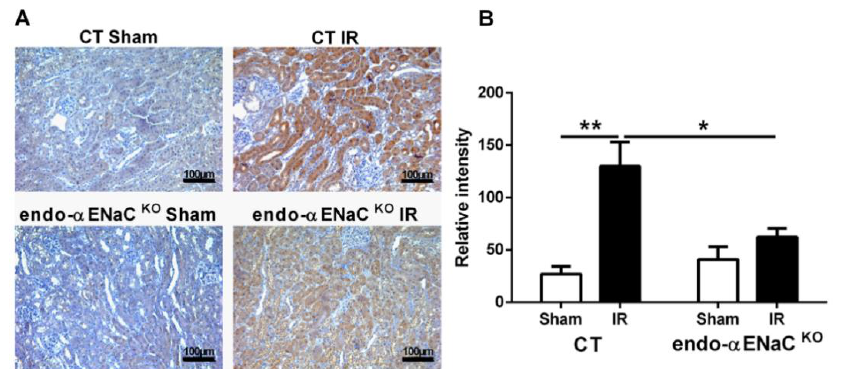
Figure 3. Endothelial αENaC deficiency promotes a faster recovery from hypoxia after IR . ( A ) Representative images from immuno-histochemistry against the pimonidazole adduct for sham and IR groups in control mice (CT) or mice with αENaC deficiency in the endothelial cells (endo- αENaC KO ) after 2 h of reperfusion. ( B ) Quantification of the relative intensity staining for the pimonidazole adduct. n = 5 per group. * p < 0.05 and ** p < 0.01.